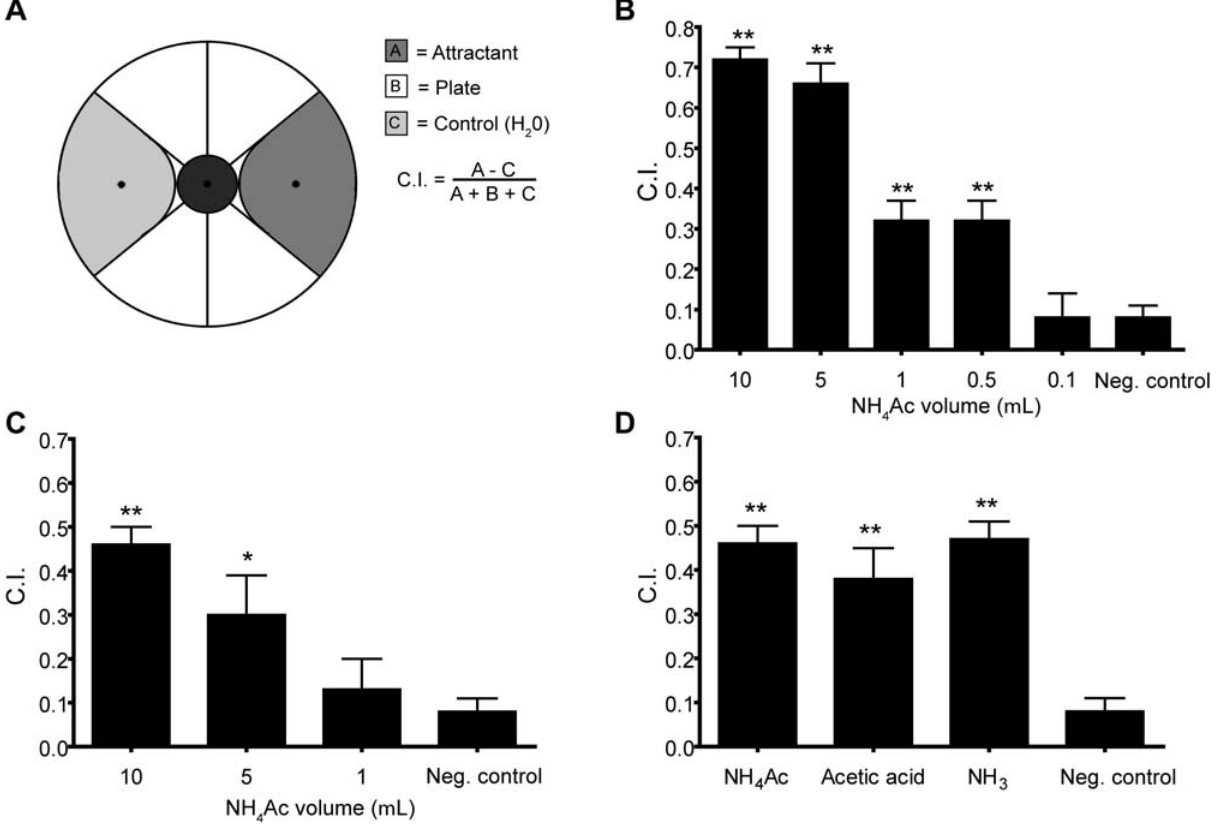
Figure 1. Odorant chemotaxis to NH 4 Ac. (A) Diagram of the assay. Droplets of attractant and negative control solutions were placed on opposite sides of plate at the locations indicated by the eccentric black dots. To manipulate effective NH 4 Ac concentrations, rather than changing NH 4